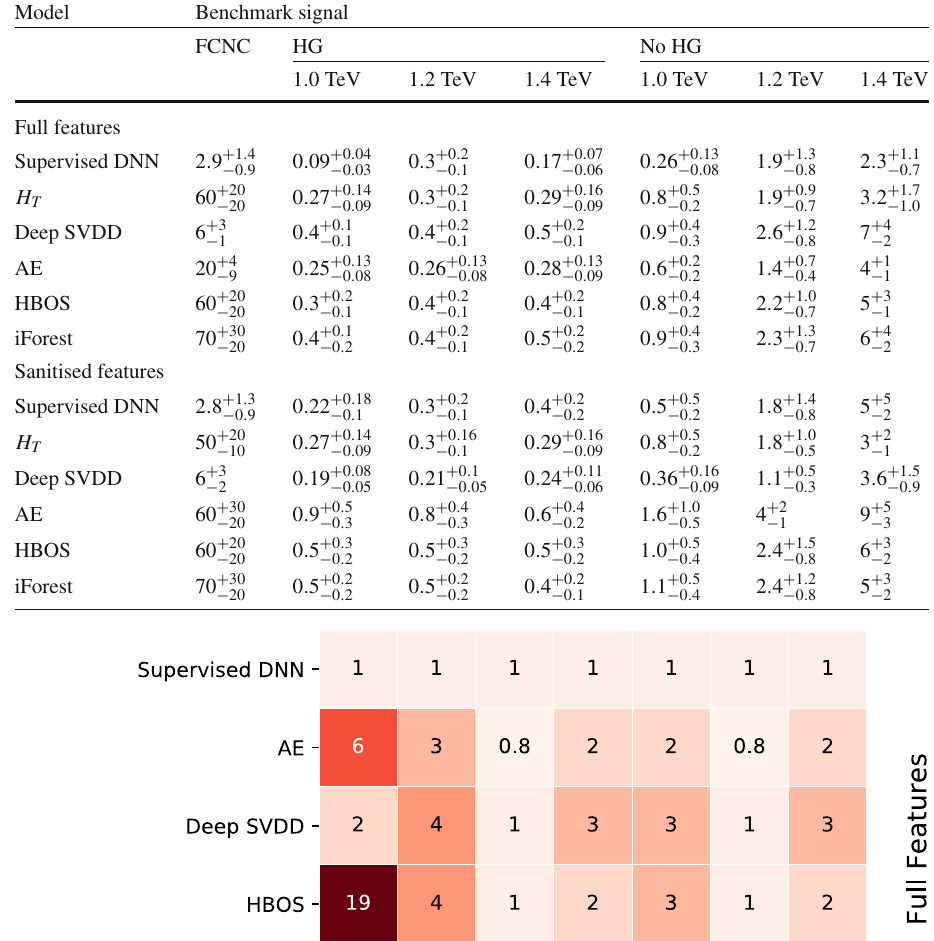
Fig. 2 95% CL upper limits on µ normalised to the limit obtained for the supervised DNN